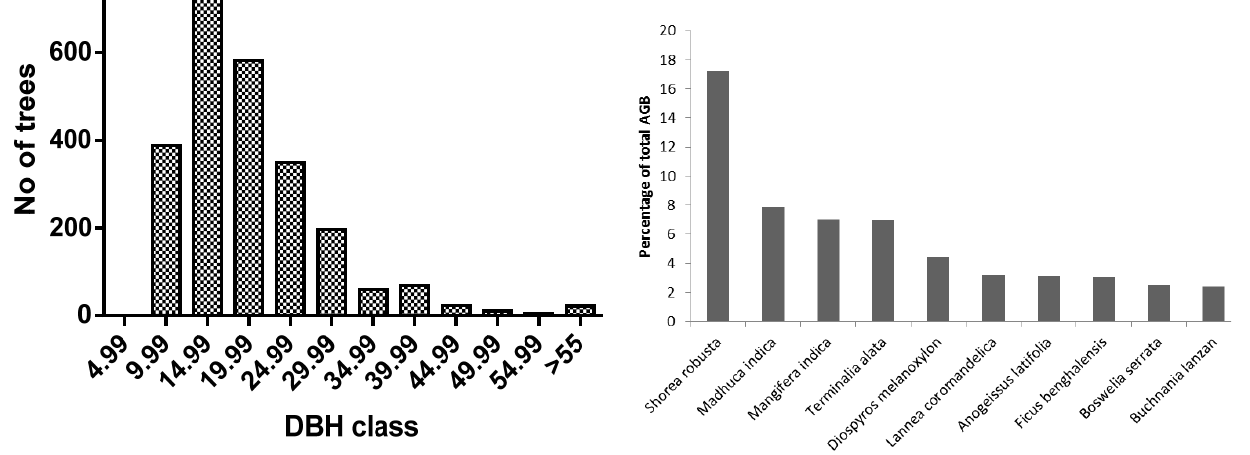
Fig. 4. Tree species contributing the most to above ground biomass (%) of the dry deciduous tropical